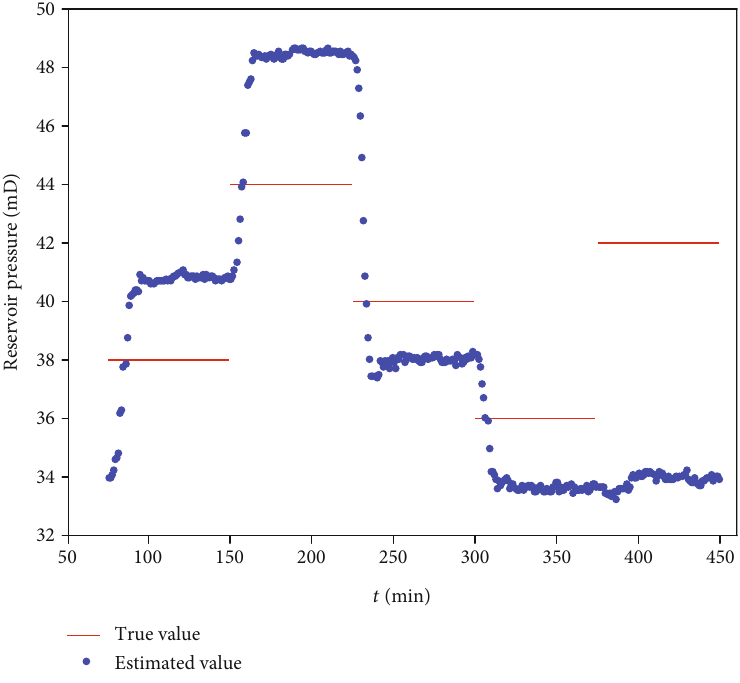
Figure 12: True and estimated reservoir pressure (case EKF algorithm are compared and analyzed, as shown in Figure 13. The simulation results are shown in Table 2. The reservoir unit is used as the estimated value. Compared with EKF, the estimated values of UKF in units 1-5 are both closer